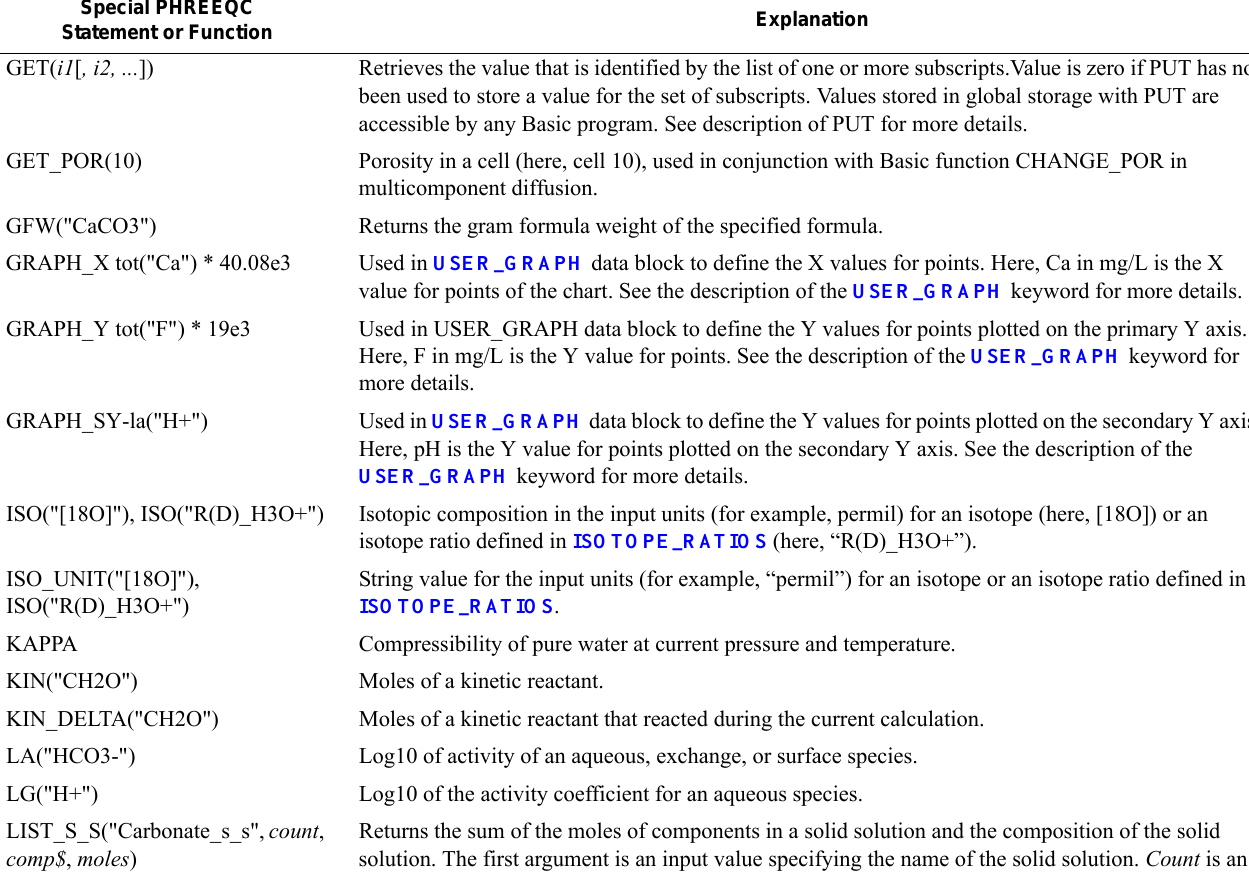
Table 8. Special Basic statements and functions for PHREEQC.—Continued Special